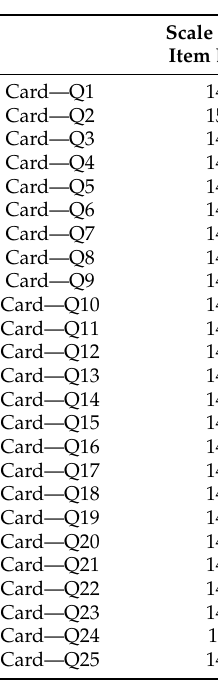
Table 5. Item—Total